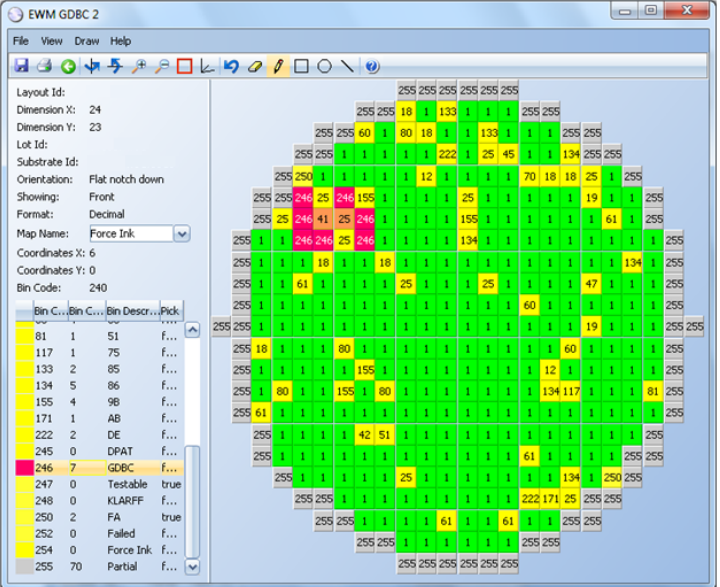
Figure 6. Bad Bin in a Bad Cluster (BBBC)